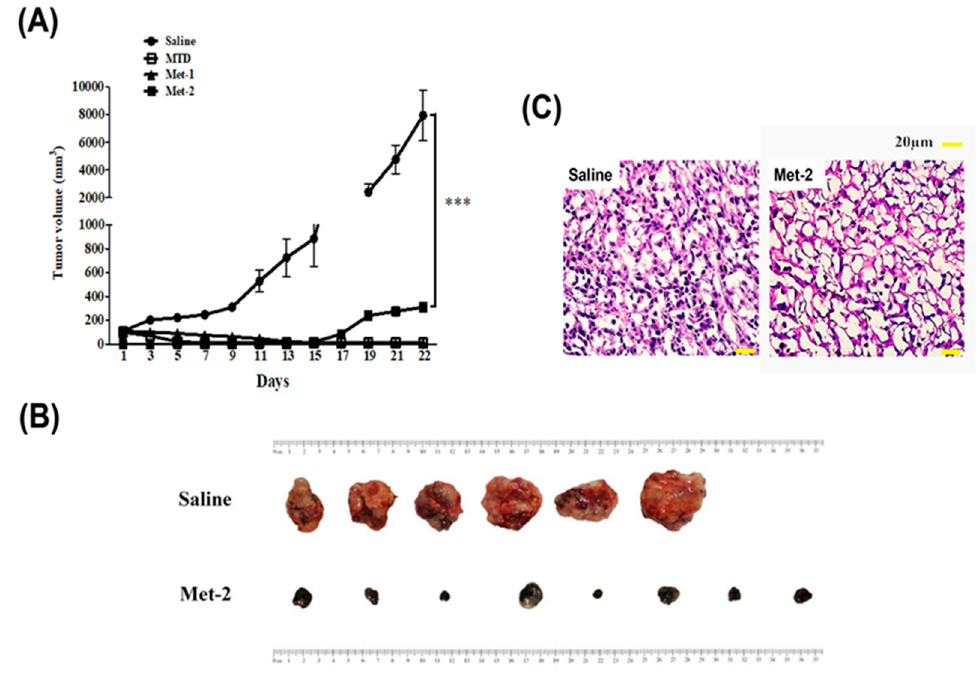
Figure 3. In vivo antitumor activity of cyclophosphamide in mice (C57BL mice) bearing LLC xenograft model. ( A ) Tumor volume of the mice in each group during the observation period. ( B ) After being administered with cyclophosphamide at a dose of 25 mg / kg every other day for 21 days, the mice were sacrificed and the tumors weighed. ( C ) H&E staining of tumor tissue from saline and Met-2 group. *** p < 0.001.